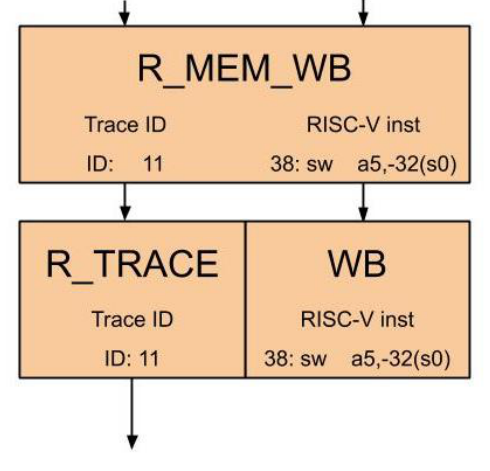
Figure 7. Trace’s instruction pair write-back stage.